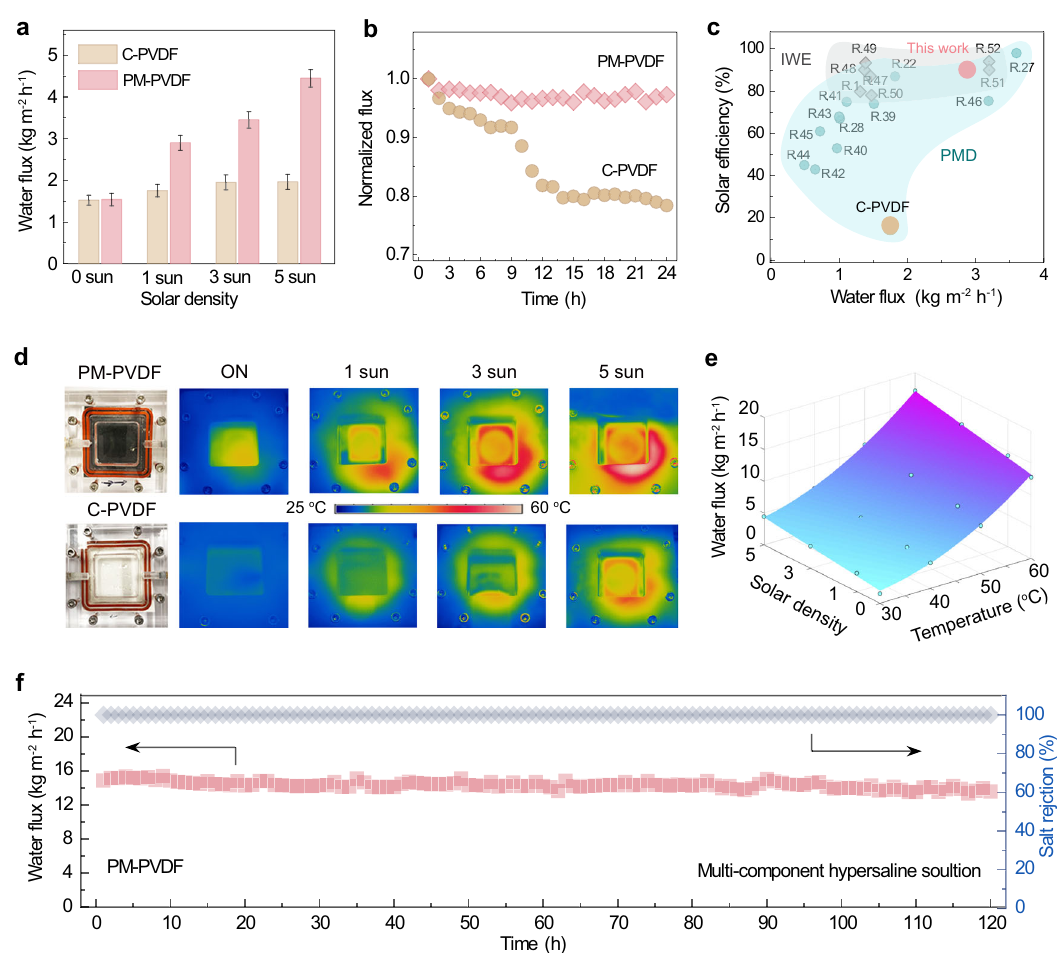
Fig. 5 Demonstration on performance of hypersaline desalination by PMD. a Freshwater production fl ux of PM-PVDF and C-PVDF membrane under different sun densities. Feed, 30 o C. b Stability evaluation of membrane in terms of normalized freshwater production fl ux. Error bars indicate the standard deviations estimated from three times measurements. c Summary of typical state-of-the-art solar desalination strategies operated in varied conditions. Solar ef fi ciency is related to solar-to-vapor conversion or utilization around 1 sun. d Surface temperature of module monitored by IR thermal image during operation. e Phase diagram and simulated model for the performance of PM-PVDF membrane. f Long-term stability of the PM-PVDF during multi- component hypersaline solution treatment under 1 sun illumination. Feed, 60 o C. Source data are provided as a Source Data fi